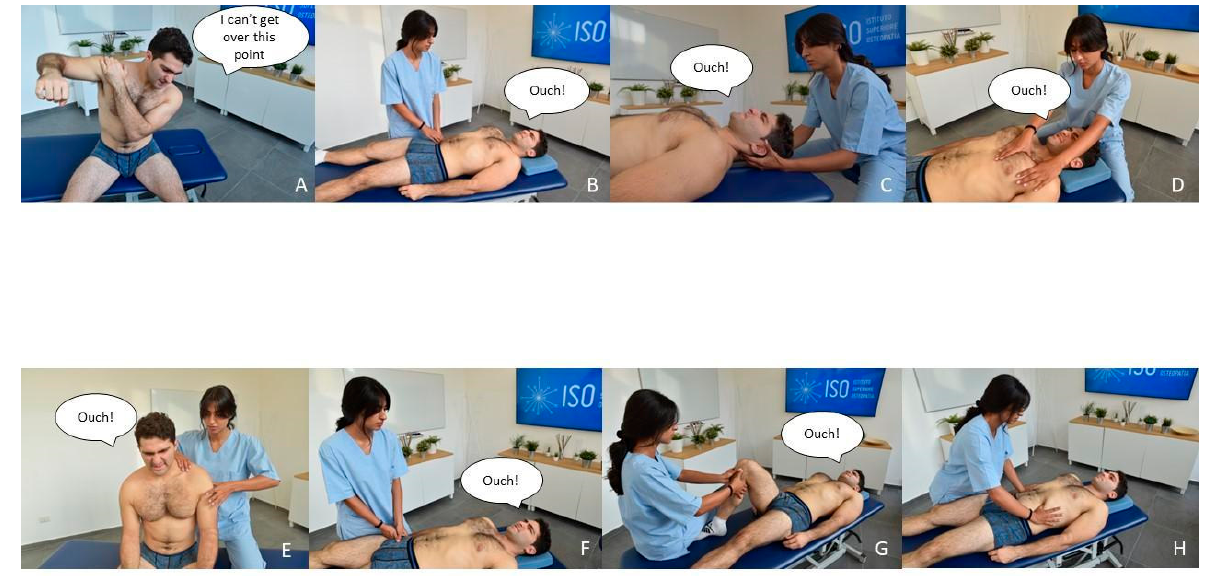
Figure A5. Clinical scenario